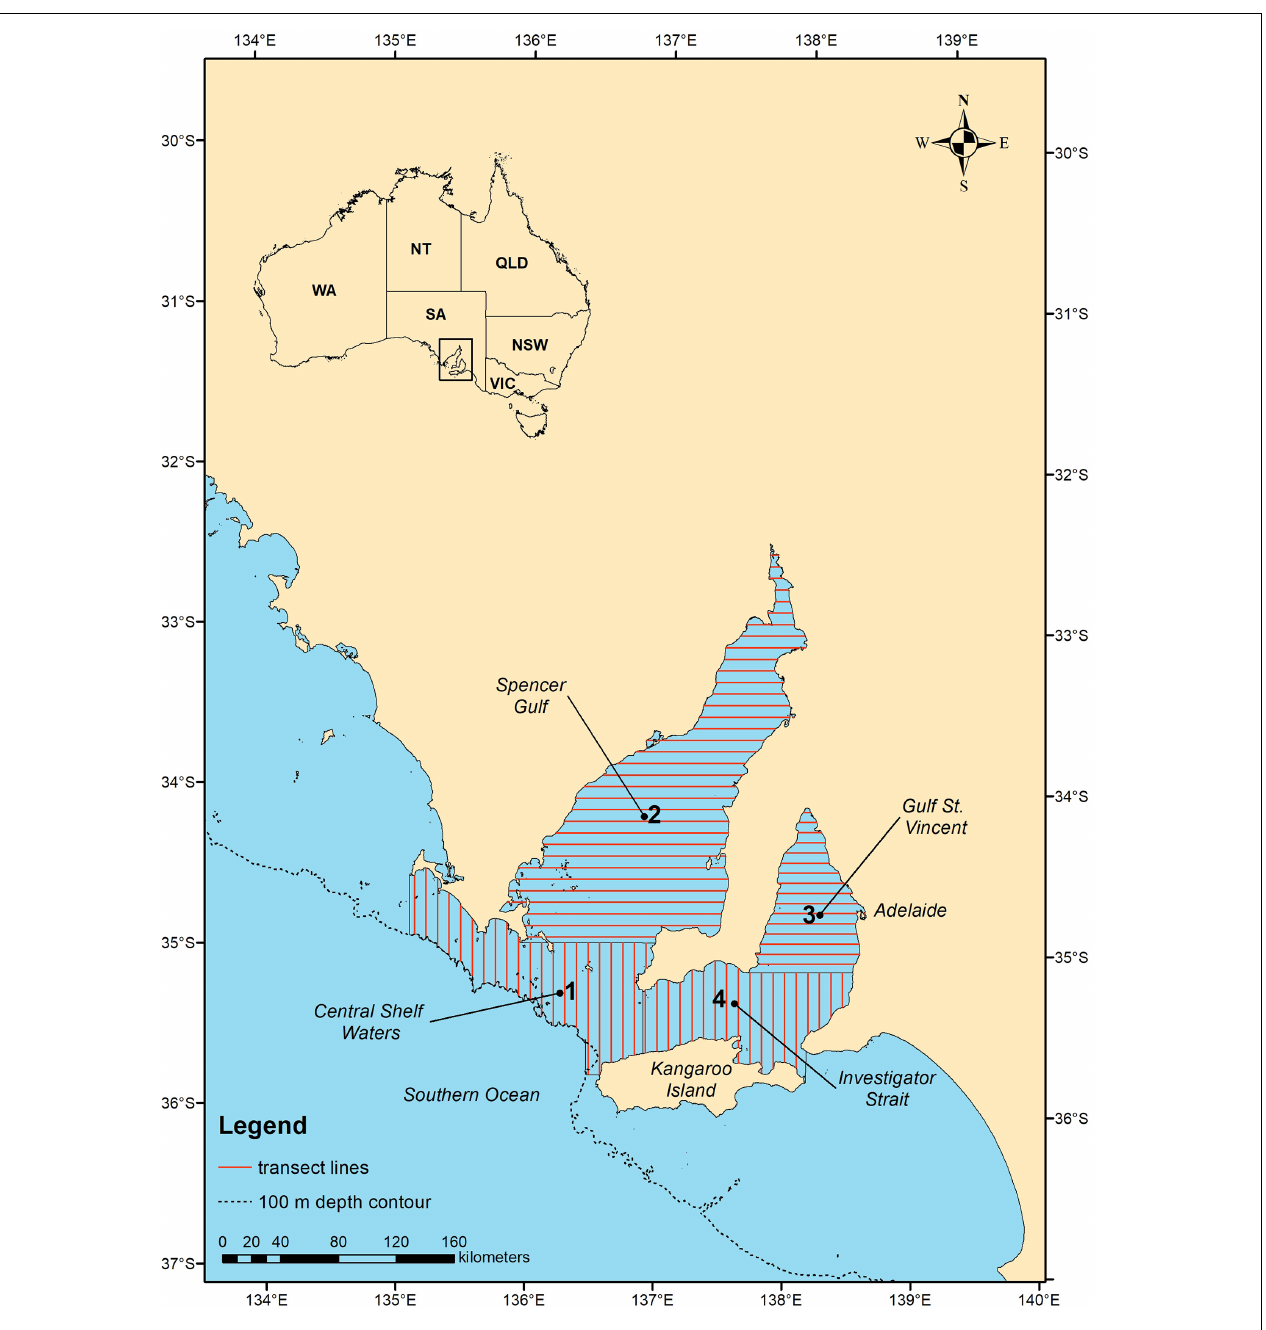
FIGURE 1 | Map of the study area indicating the four aerial survey strata (numbers in bold), transect line layout (red lines). Black lines indicate the coastline, the divisions between strata, and for the southern section of stratum 1 the 100 m depth contour of the Australian continental shelf.